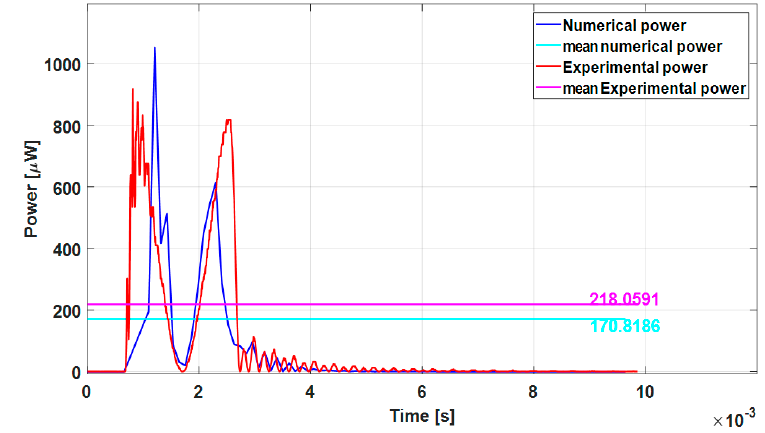
Figure 15. Experimental and numerical power vs. time plots.